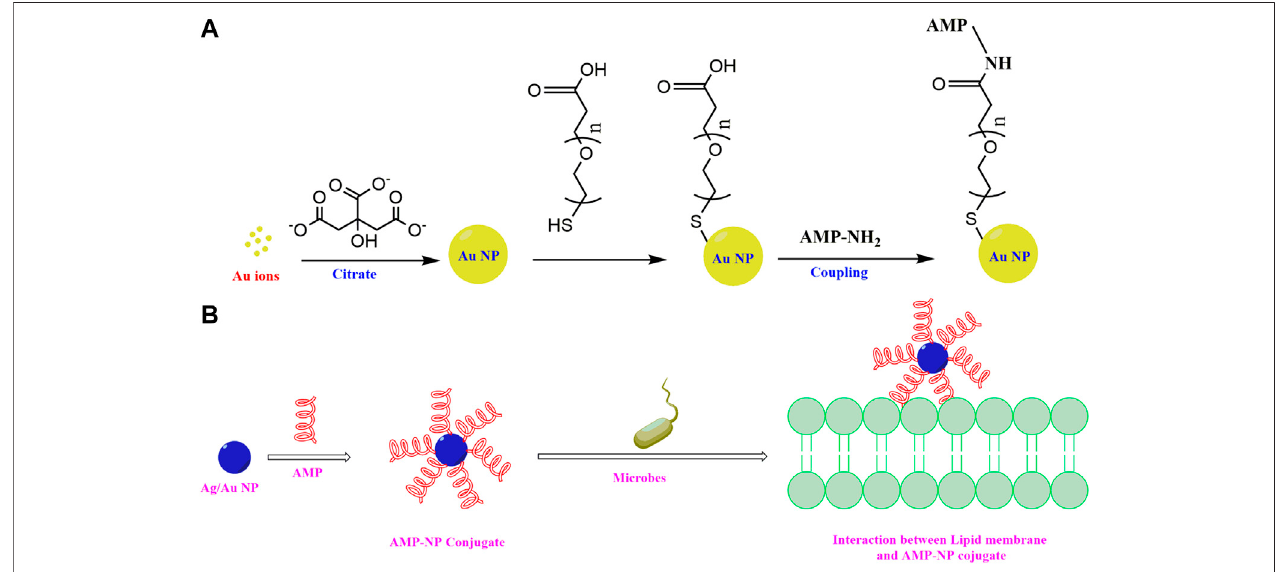
FIGURE11| Schematicof (A) StepwisesynthesisofAMP-AuNPconjugatesand (B) FormationofAMP-NPconjugatesandtheiractiononlipidmembraneofthemicrobes.